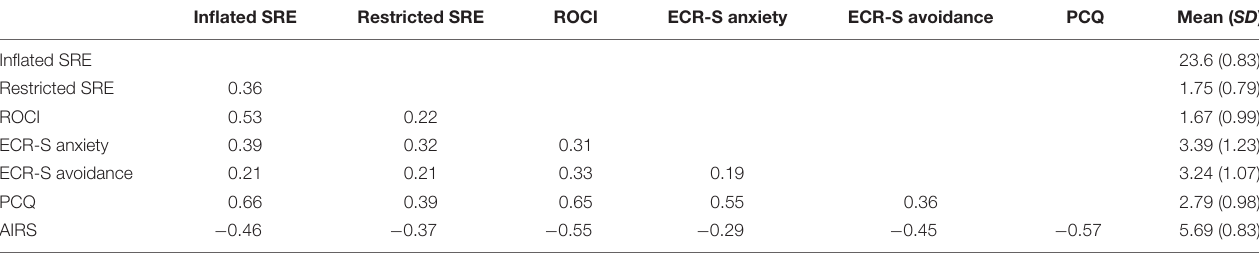
TABLE 1 | Correlations between SRE-R subscales and ROCI, PCQ, AIRS, and ECR-S subscale scores (min n = 446). Inflated SRE